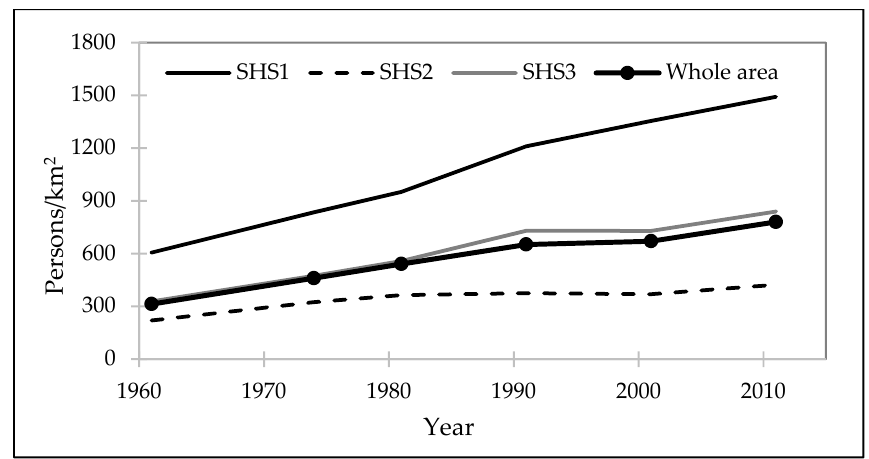
Figure 2. Population density of the study area in the period 1961–2011.